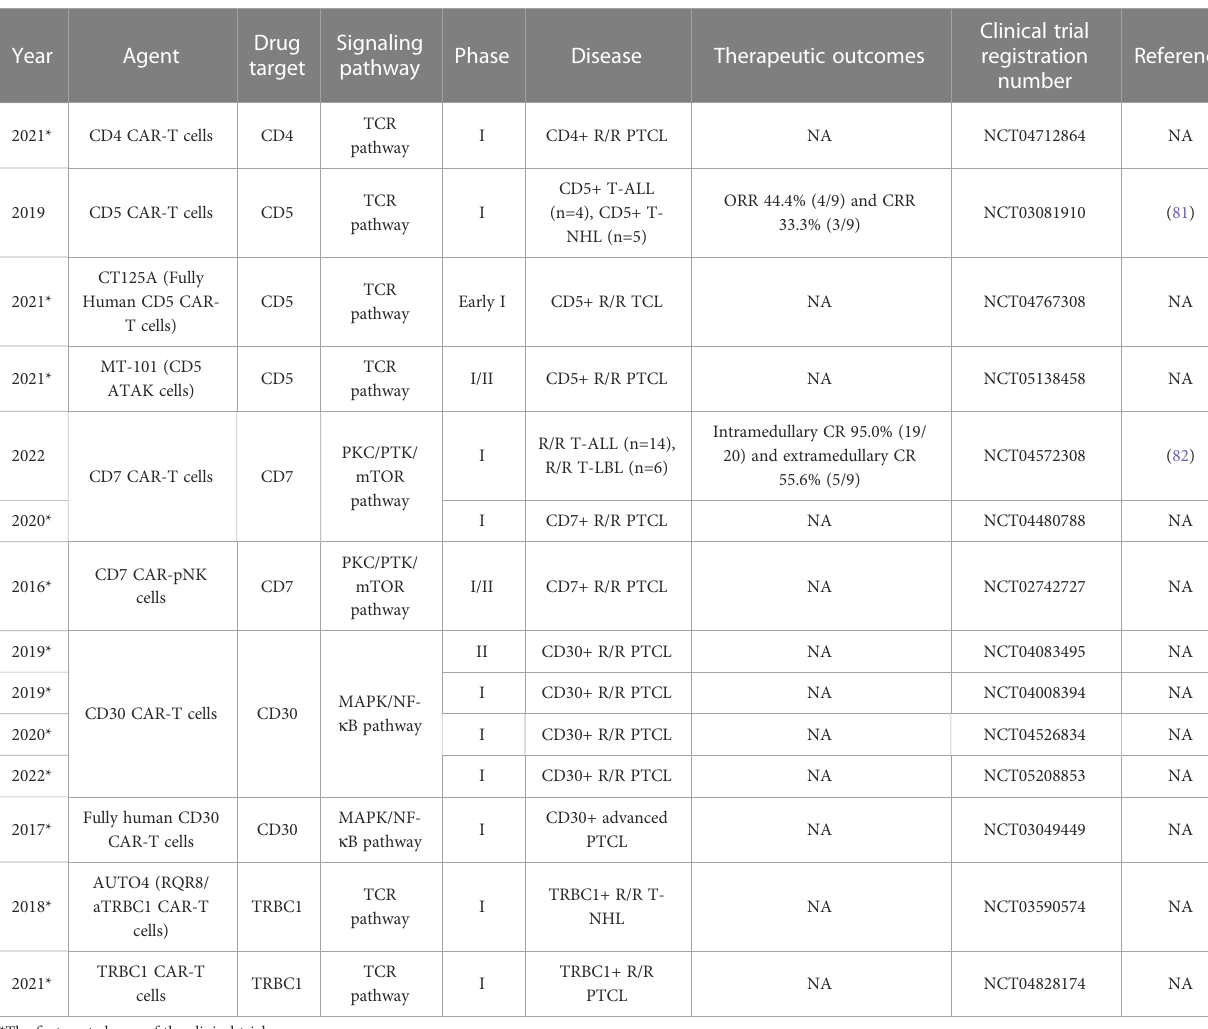
*The fi rst posted year of the clinical trial. CAR-T, chimeric antigen receptor T; CAR-pNK, chimeric antigen receptor pNK; NA, not acquired; ORR, overall response rate; CRR, complete response rate; R/R, relapsed/refractory; PTCL, peripheralT-celllymphoma;T-ALL,T-acutelymphoblasticleukemia;T-NHL,T-non-Hodgkinlymphoma;TCL,T-celllymphoma;T-LBL,T-celllymphoblasticlymphoma;mTOR,mammalian target of rapamycin; TCR, T-cell receptor; MAPK, mitogen-activated protein kinase; PKC, protein kinase C; PTK, protein tyrosine kinase; NF- k B, nuclear factor kappa-B; CD, cluster of differentiation; TRBC1, T-cell receptor b -chain constant domain